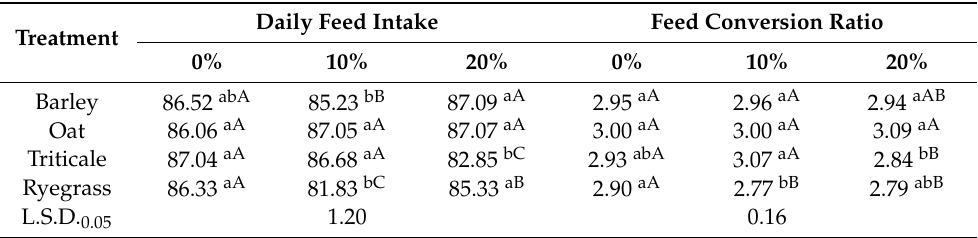
Table 4. Means of the daily feed intake (g) and feed conversion ratio as affected by the interaction between the crop and its percentage in the diet.